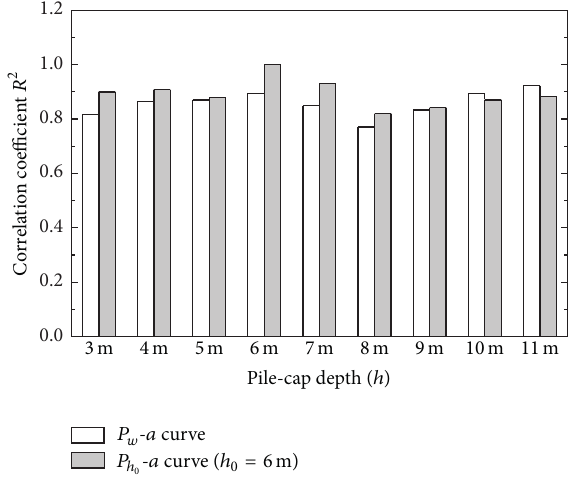
Figure 18: Comparison of different benchmark curves (10,000